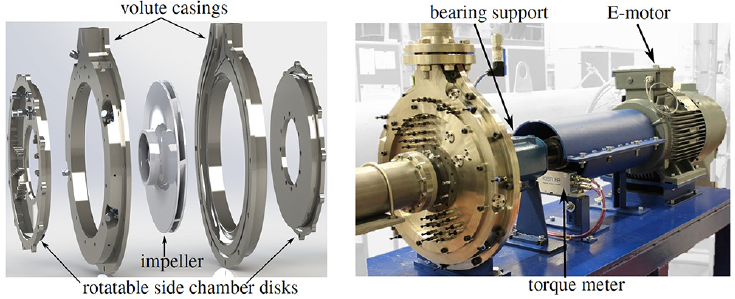
Figure 16. Details of the test pump. The figure is taken from Ref. [2].